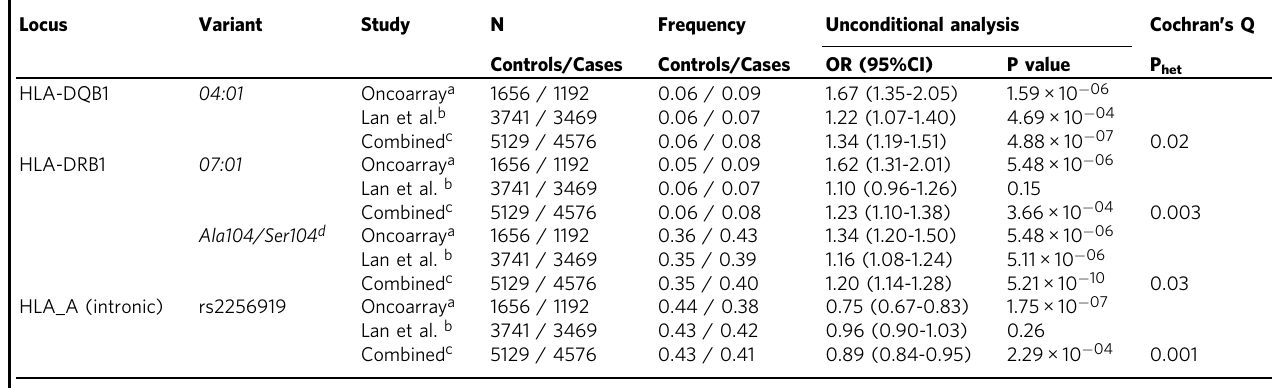
Table 5 Meta-analyses of top associated HLA variants with adenocarcinoma of Asian ancestry